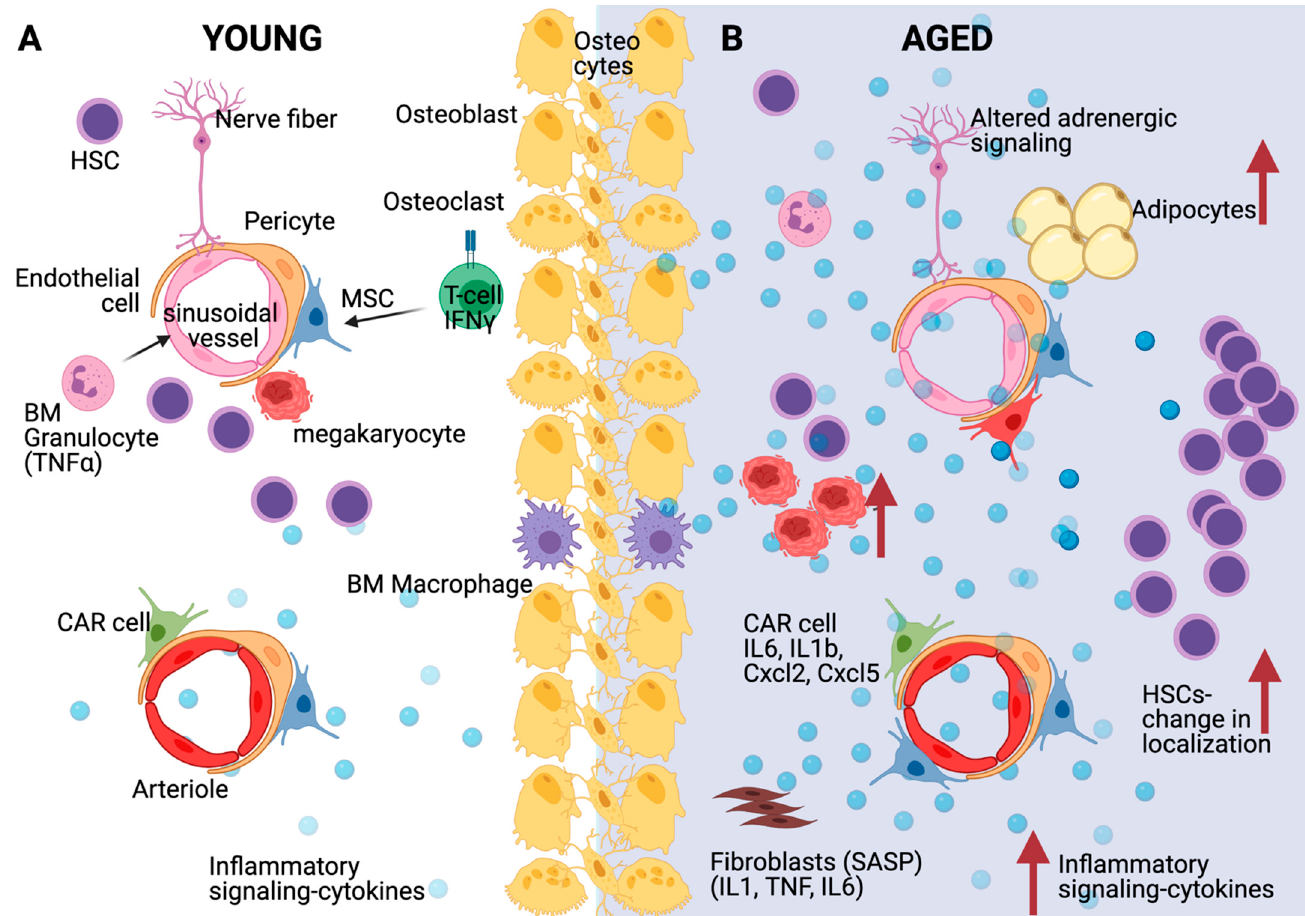
Figure 2. Effects of inflammation and aging on the HSC niche. ( A ) Multiple bone marrow niche cells such as mesenchymal stromal cells (MSCs) and specifically CXCL12-abundant reticular (CAR) cells, endothelial cells, but also hematopoietic cells such as megakaryocytes, T-cells and macrophages affect HSC quiescence through diverse molecular mechanisms, including cytokine secretion as depicted. ( B ) During aging, HSC accumulation but with increased distance from arterioles, sinusoids and megakaryocytes is accompanied by inflammatory signaling and cytokine secretion from various bone marrow populations including CAR cells and senescent fibroblasts (SASP: Senescence-associated secretory phenotype). Aged MSCs turn primarily into adipocytes and adrenergic signaling is disturbed. Created with BioRender.com, accessed on 3 June 2021.